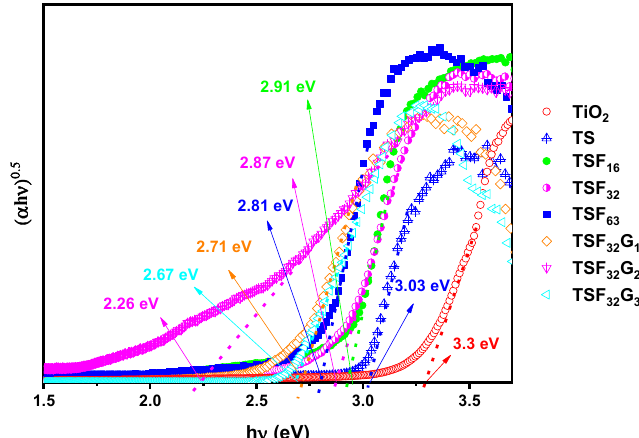
Figure 6. Tauc plots of ( α h ν ) 0.5 versus h ν were employed to estimate the band gaps of the TiO 2 , TS, TSF, and TSF 32 G coated films with different loadings.